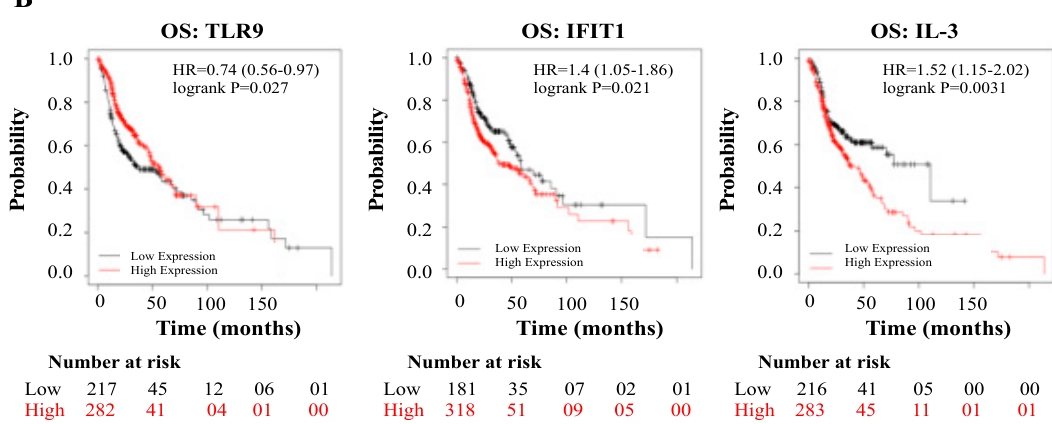
Figure 3. ( A , B ): Relapse-free survival (RFS) in HN cancer patients using the Kaplan–Meier plotter database, expressed by relapse-free survival (RFS) and overall survival (OS).